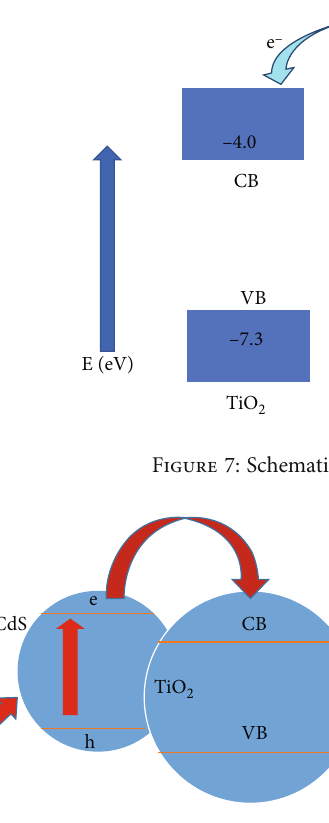
Figure 8: Energy band diagram of the CdS-TiO